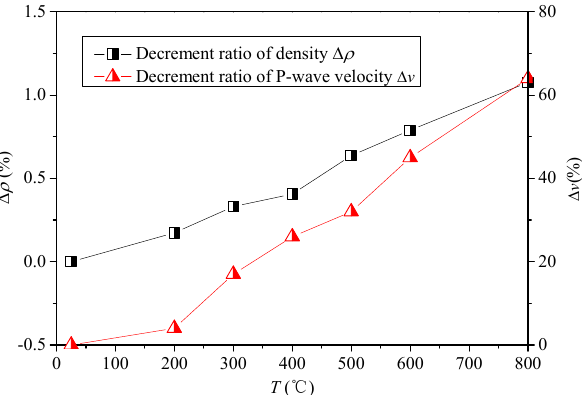
Figure 3. Effect of temperature on the decrement ratio of density and P-wave velocity of the tested granites.